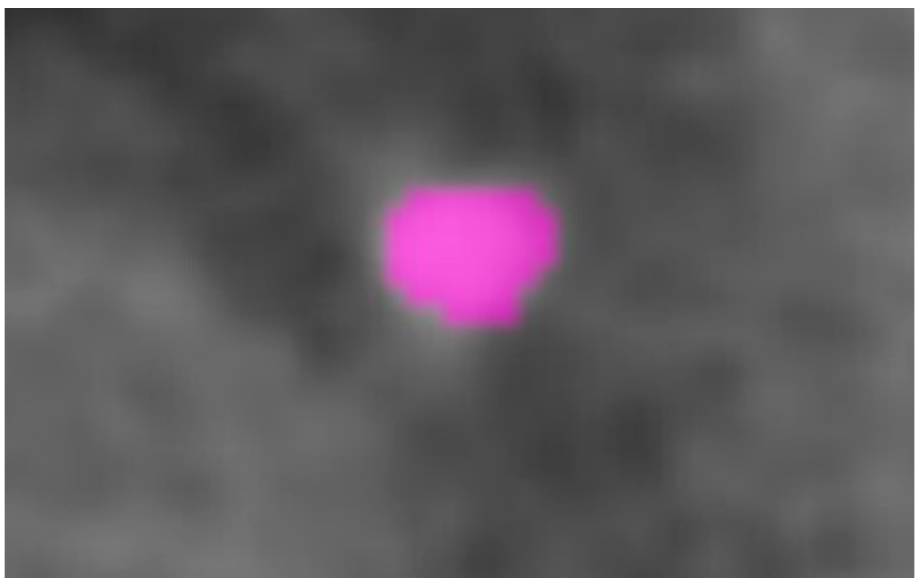
Figure 5. Semiautomatic segmentation using circle 3D technique in LIFEx software in bone window setting on the coronary blood vessel.